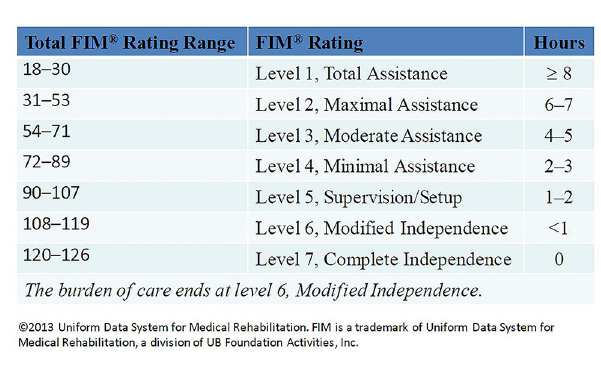
Data System for Medical Rehabilitation (22), FIM total